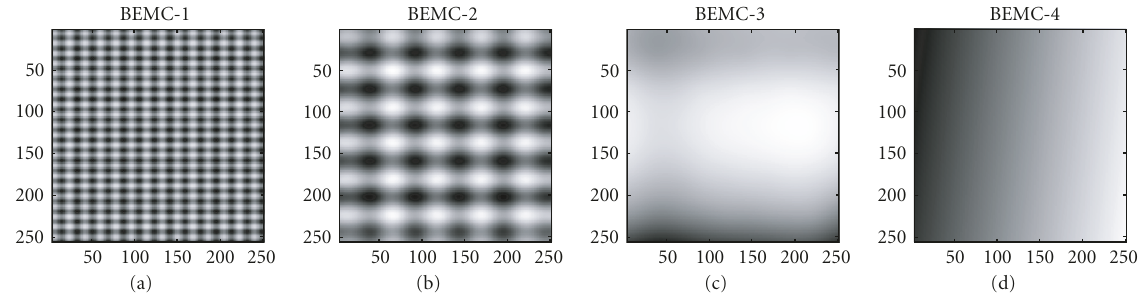
Figure 16: BEMCs of the STI obtained by BEMD with RBF-TPS (MNAI = 1).